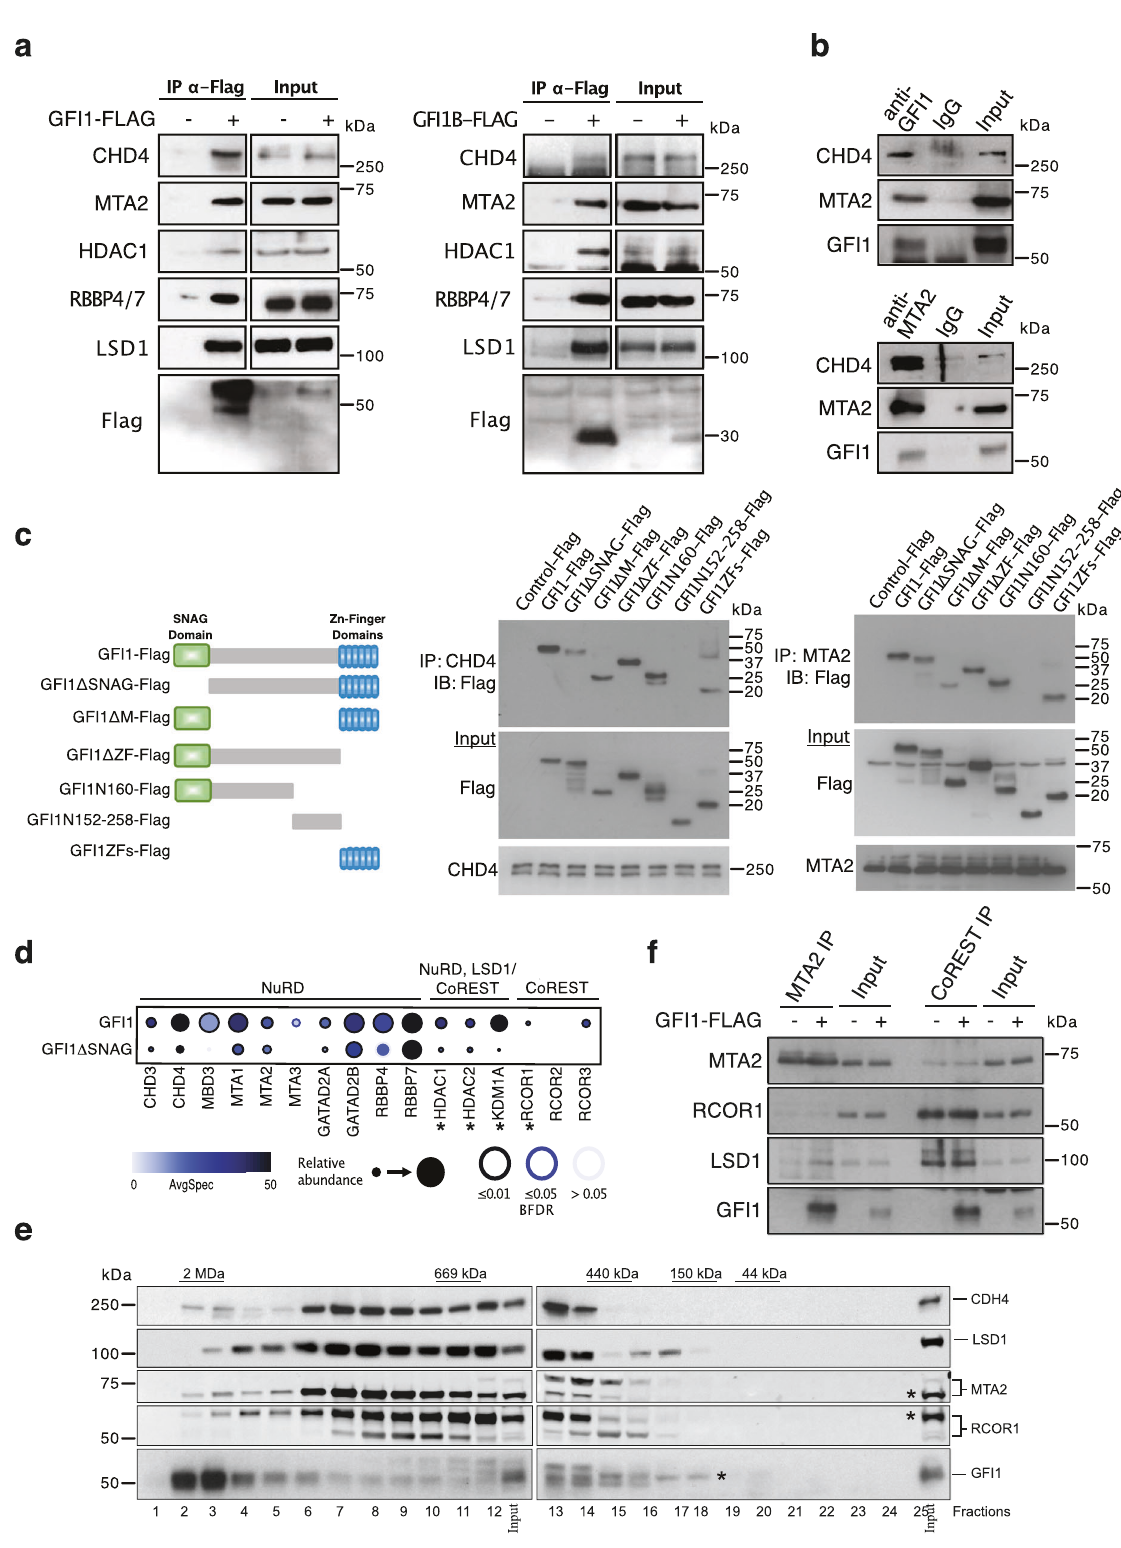
Table 3). This suggested that the deletion of GFI1 affects gene expression independently of the presence of